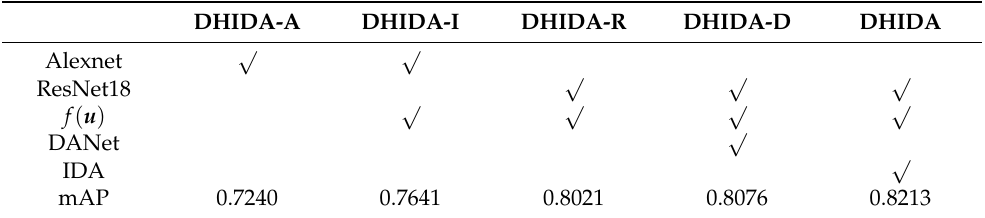
Table 4. Ablation